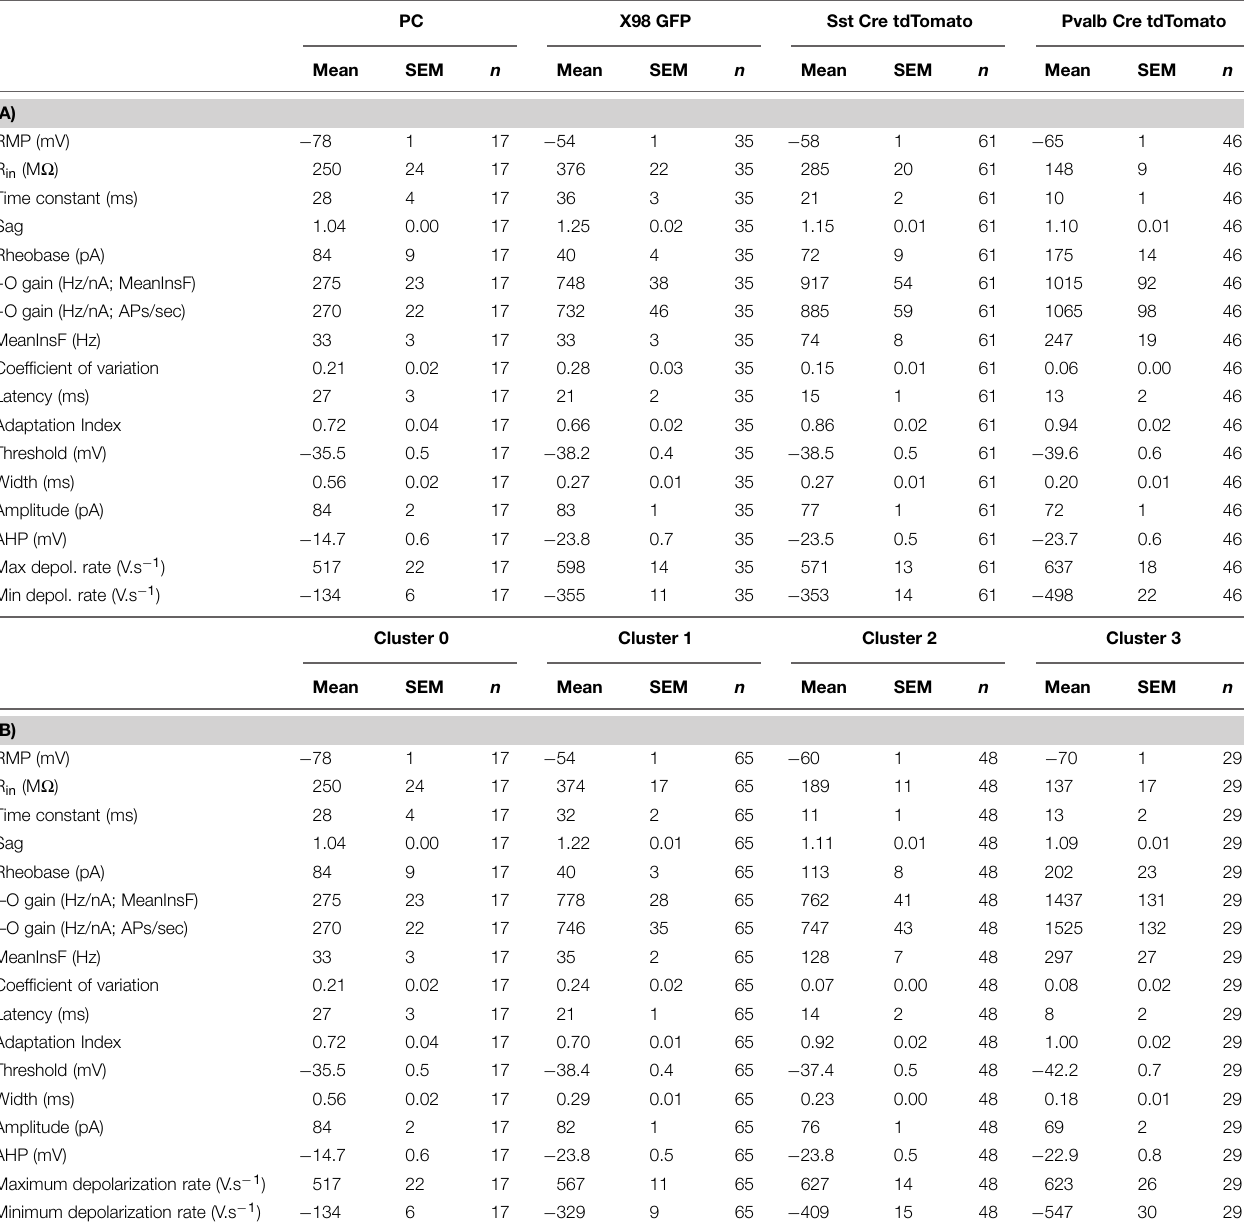
TABLE 1 | Electrophysiological parameters (mean ± SEM) of presubicular pyramidal cells (PC, n = 17) and interneurons recorded from the three mouse lines (X98 GFP, 35; Sst-Cre tdTomato, 61; Pvalb-Cre tdTomato, 46). Using these parameters for Ward’s unsupervised cluster analysis permitted separation of clusters 0, 1, 2, and 3. Values (mean ± SEM) for each parameter are given for each cluster in